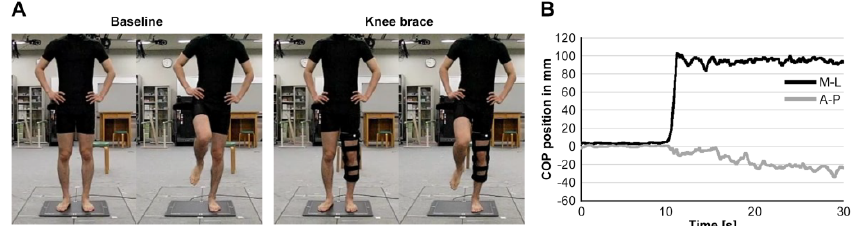
Figure 1. Initial and target posture of the DLS-SLS test (( A ): Baseline, Knee brace) and the mediolateral (ML) and anteroposterior (AP) COP trajectories ( B ).